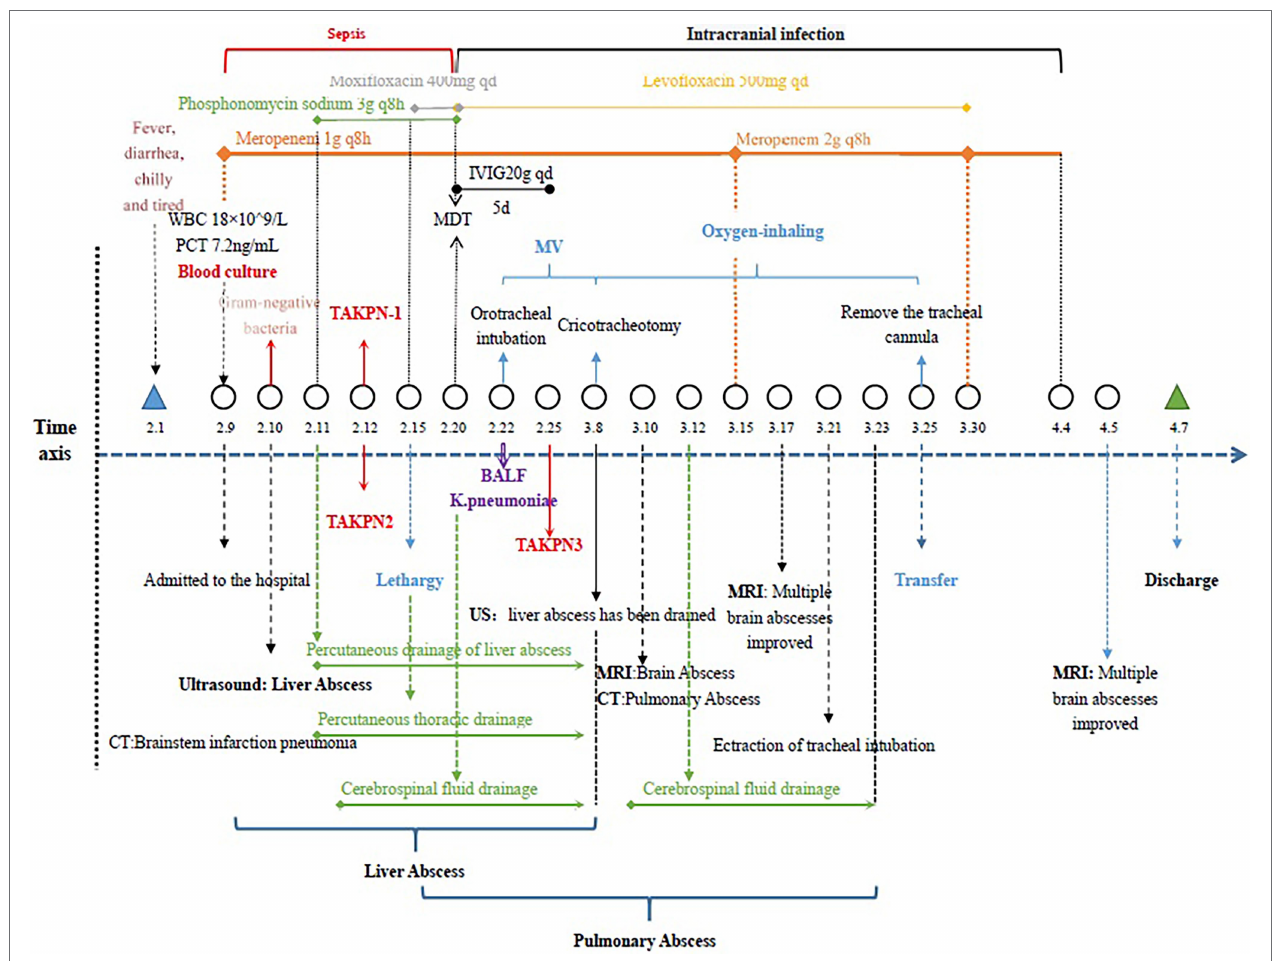
FIGURE 2 | Clinical characteristics and treatment process of the